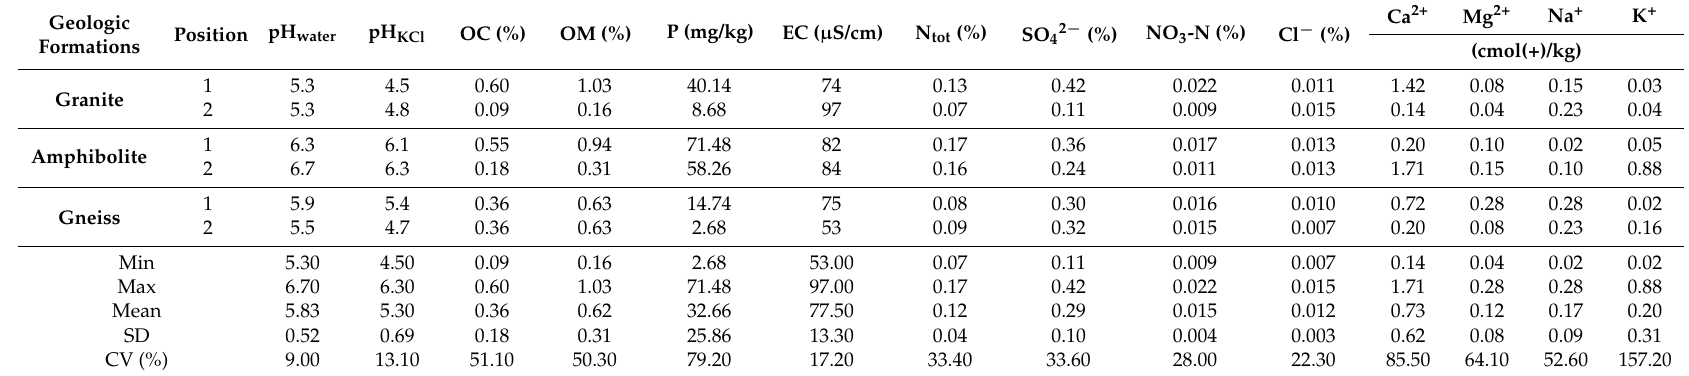
Table 2. Physicochemical results of soil samples.